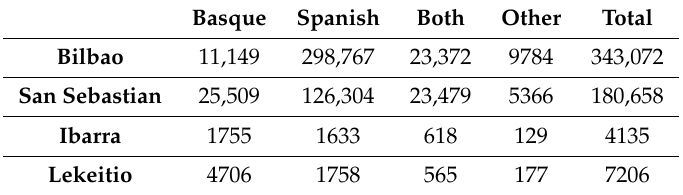
Table 11. Number of speakers who used Basque at home in 2016 (Eustat